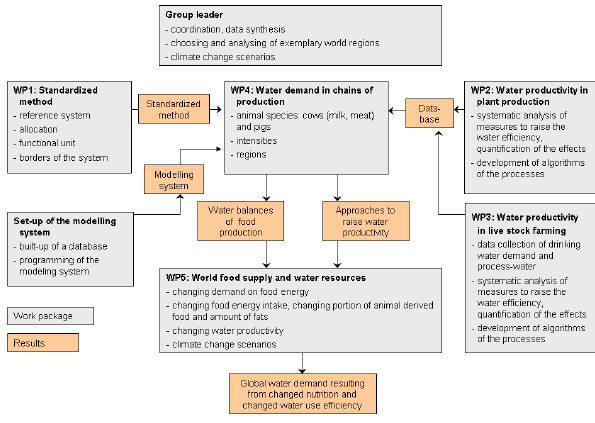
Fig. 2. Work arrangements and group